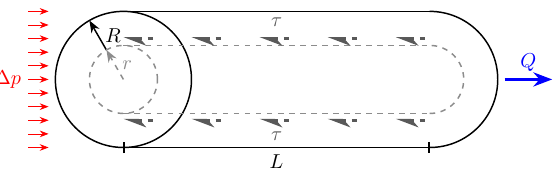
Figure 1: Poiseuille pipe flow configuration expresses a longitudinal force equilibrium between pressure loss ∆p and internal shear stress τ as a function of pipe radius r